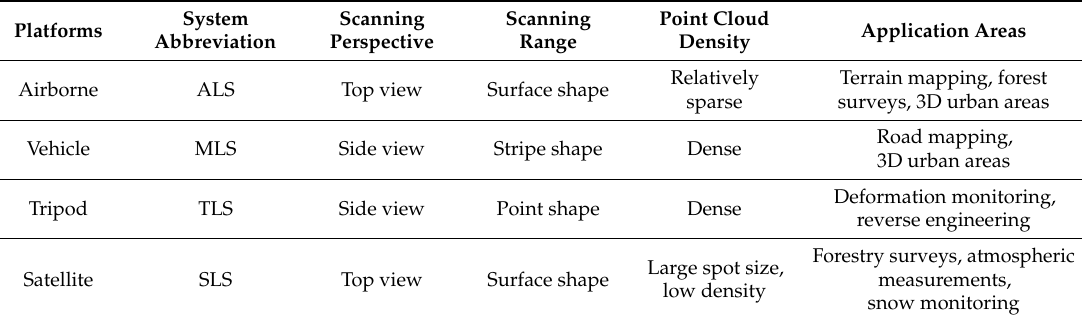
Table 1. Comparison of LiDAR systems mounted on different platforms.